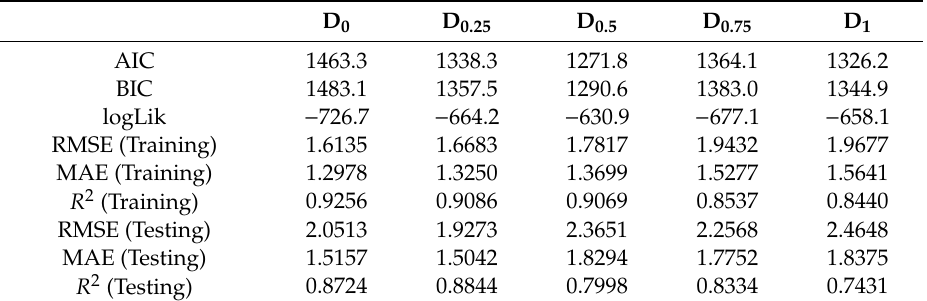
Table 4. The summary statistics of optimal H-D models for five competition levels from 10-fold cross-validation.